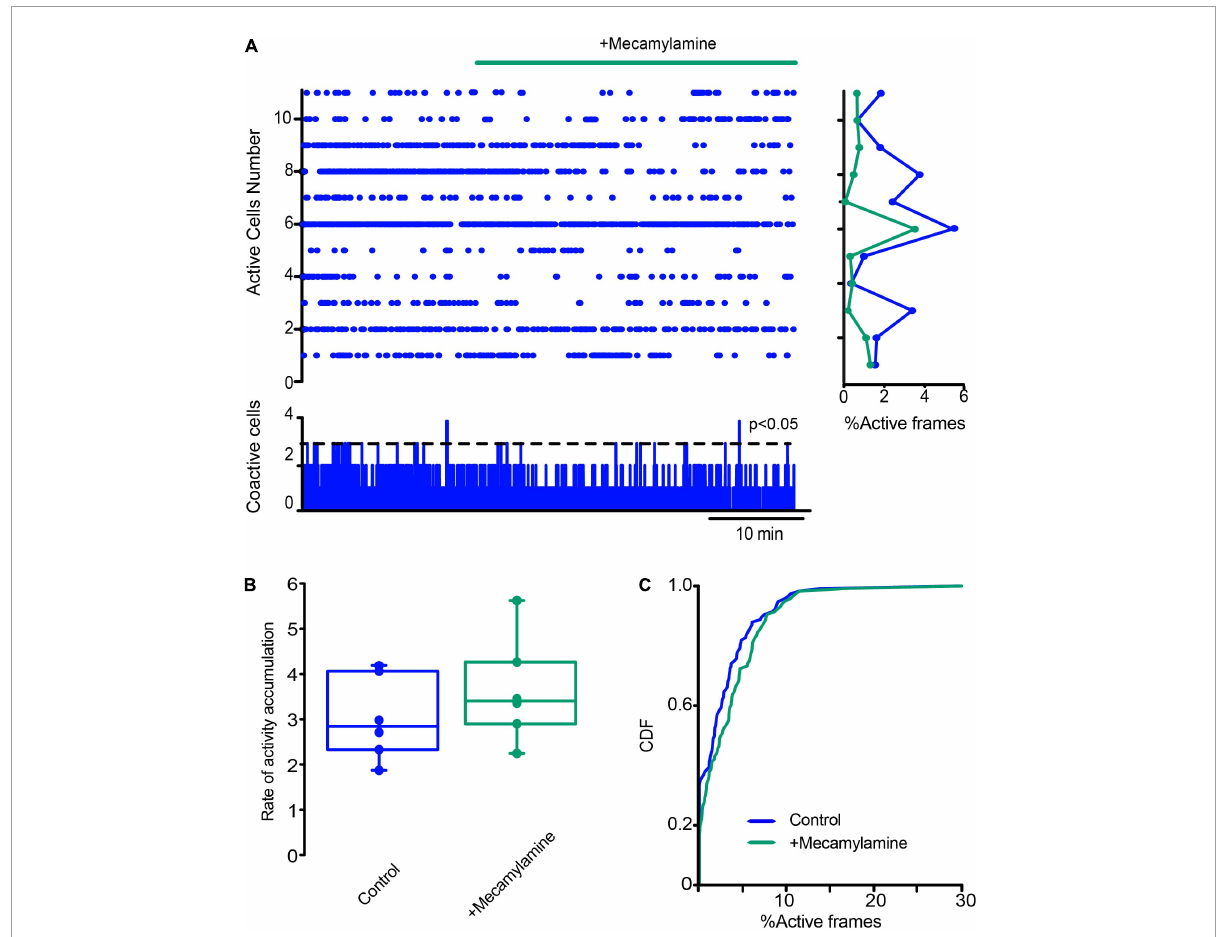
FIGURE11 Blockade of nicotinic receptors does not have an obvious influence on CINs activity in control conditions. (A) The raster plot shows the simultaneous activity of CINs before and after applying the nicotinic receptor antagonist mecamylamine (10 µ M). (B) Box plots of the rate of activity accumulation. (C) Cumulative distribution function of activity of ChAT+ neurons with and without mecamylamine: P = 0.063 (Kolmogorov-Smirnov test: CINs control = 77 neurons; with mecamylamine = 97 cells; from n = 6 slices from 6 different